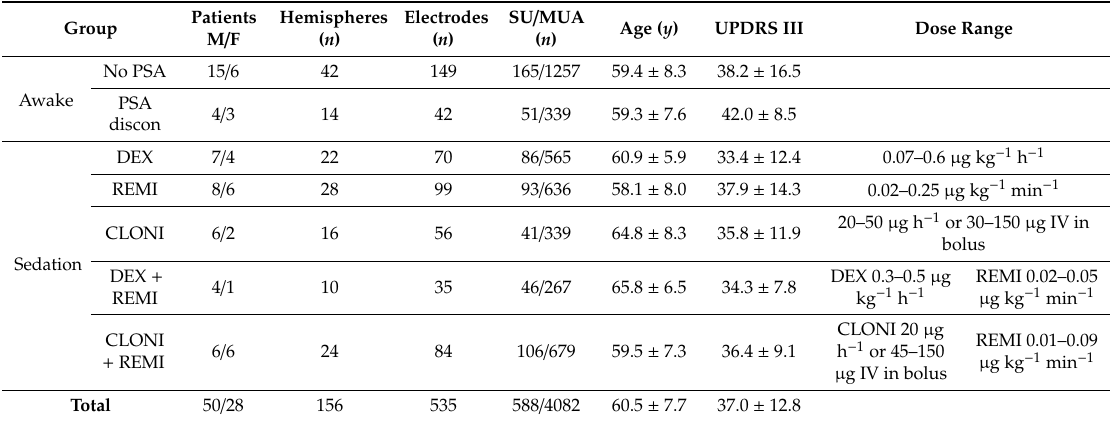
Table 1. Demographic and clinical data of all